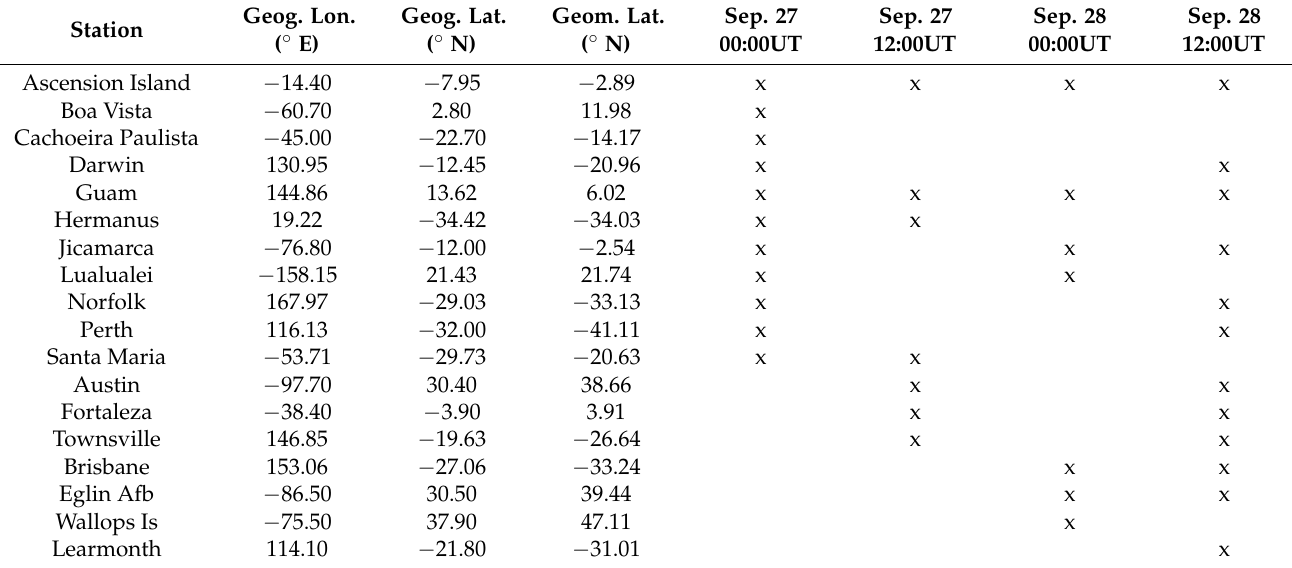
Table A5. Geographic and geomagnetic locations of the ionosondes used during 27–28 September 2020 (‘x’ indicates that the ionosonde was used at the specific